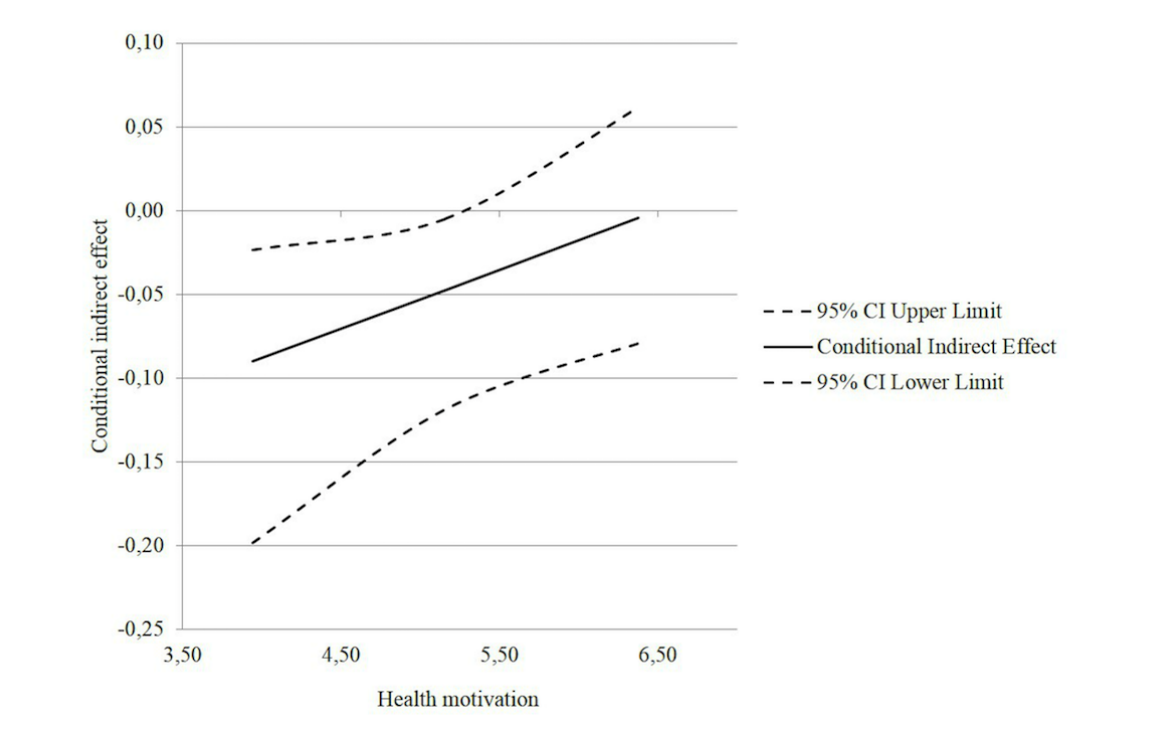
Figure 5. Conditional indirect effect of hedonic editing opportunity on health behavior intentions at values of the moderator health motivation through compensatory health